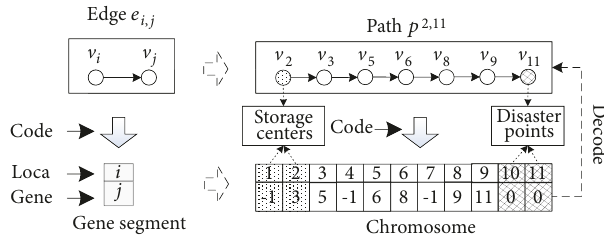
Figure 2: A description of